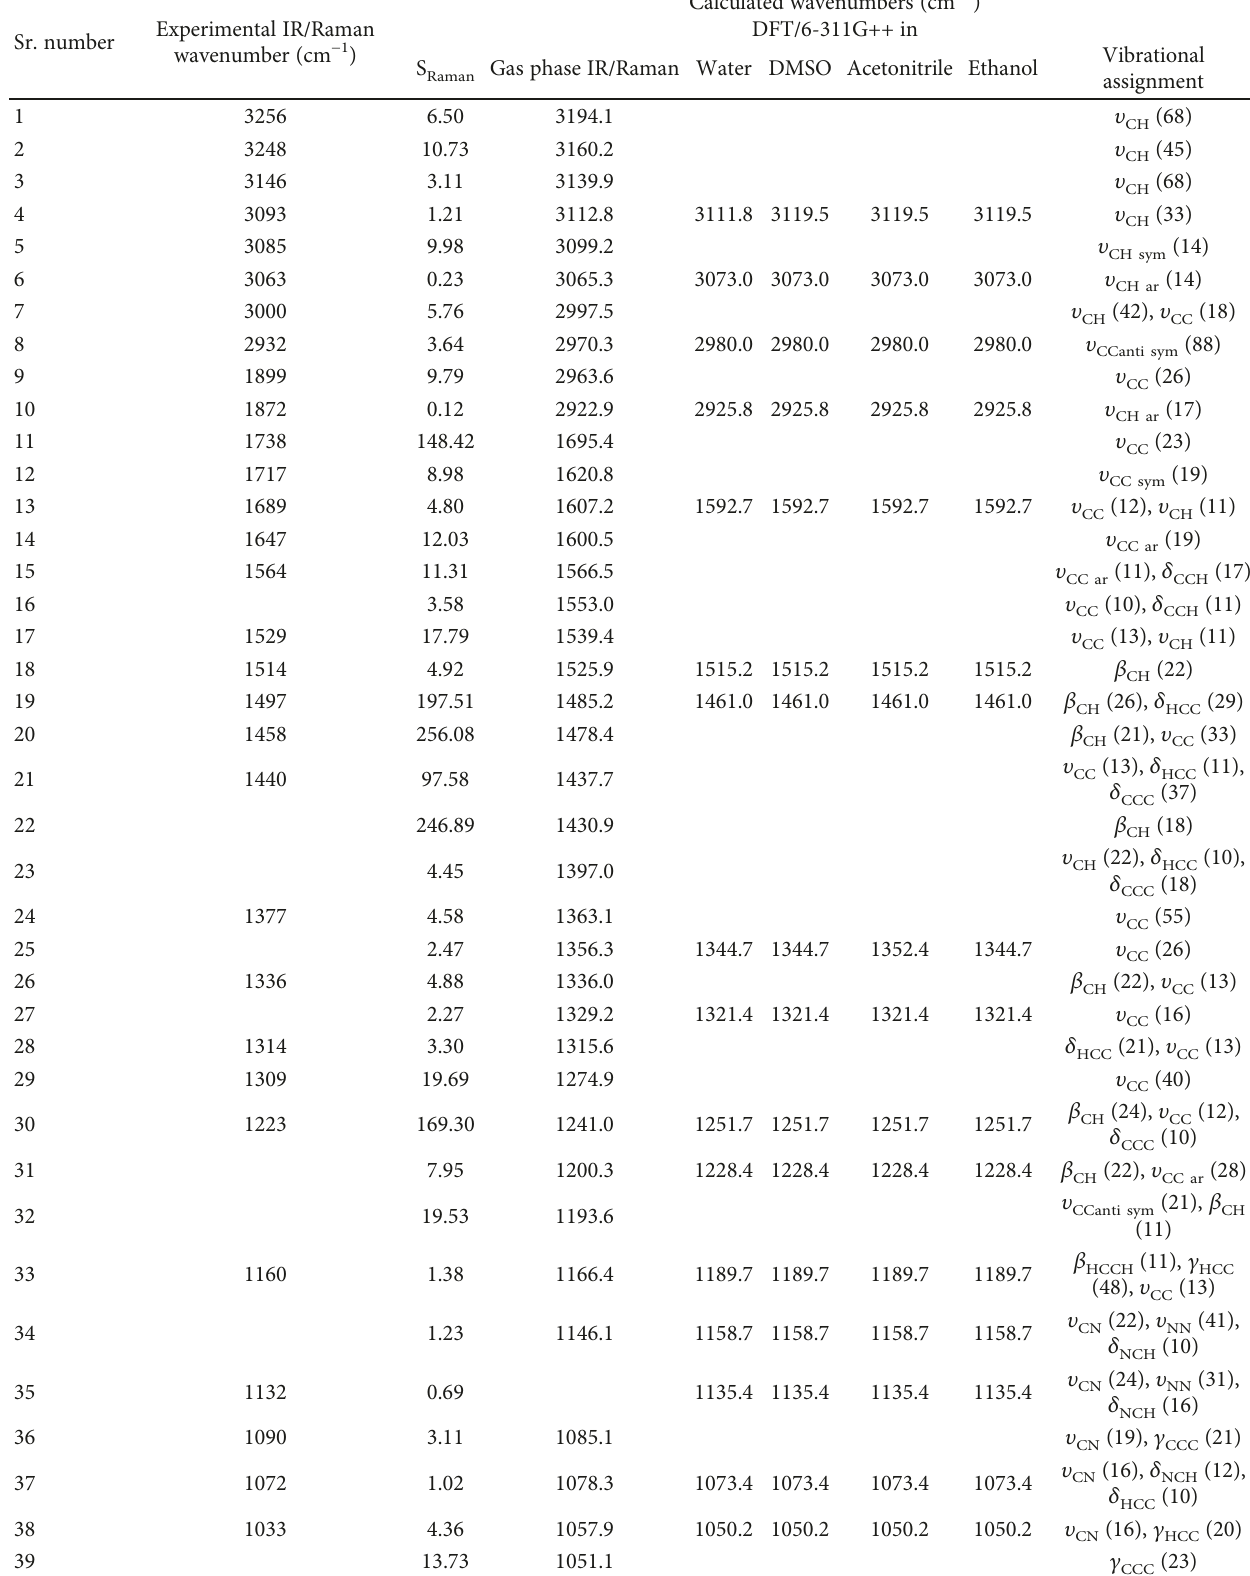
Table 2: Comparison of experimental FTIR/FT-Raman and calculated (scaled) IR/Raman (gas) & IR vibrational frequencies (cm − 1 ) of DMAB in di ff erent solvents employing DFT/B3LYP/6-311G++ with Raman activity and probable assignment (characterized by PED). Sr.